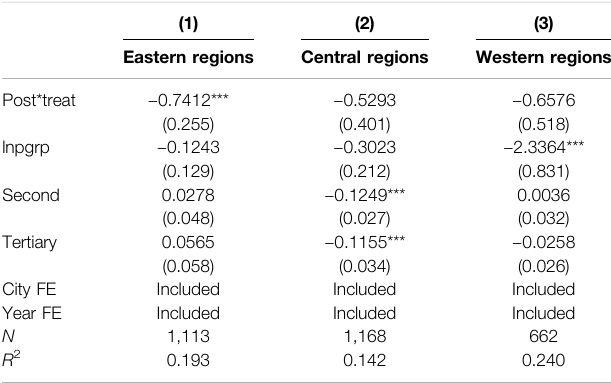
TABLE 5| Theheterogeneousimpactsofthepilotpolicyon theenergy intensityin different geographical